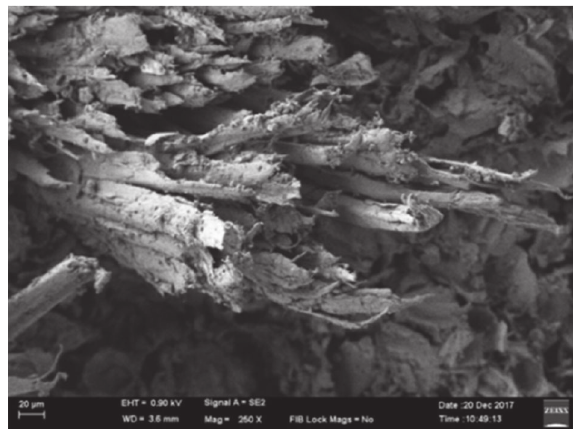
Figure 6: Bamboo fibre pull-out behaviour under FESEM inspection.